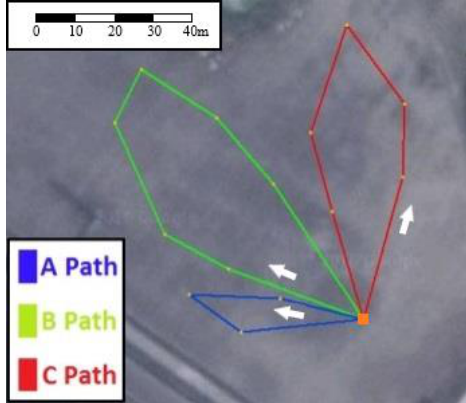
Figure 11. Shortest Total Distance Path When the Maximum Distance Limit Is 170 m.